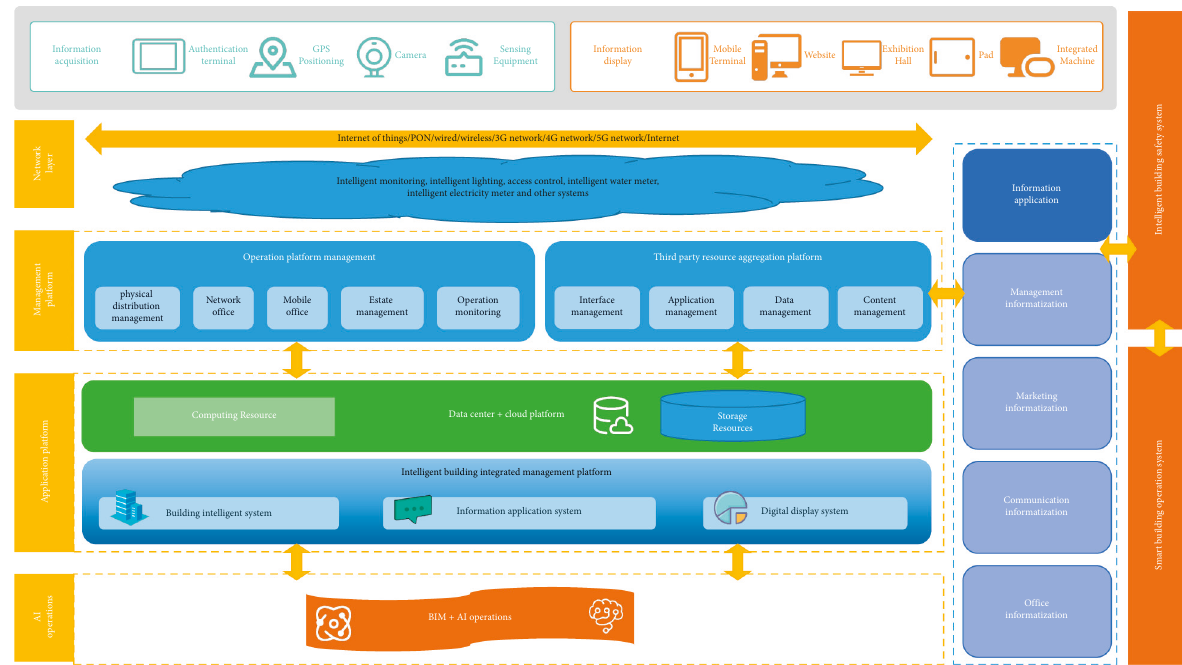
Figure 1: Overall architecture of intelligent building based on the combination of BIM and artificial intelligence